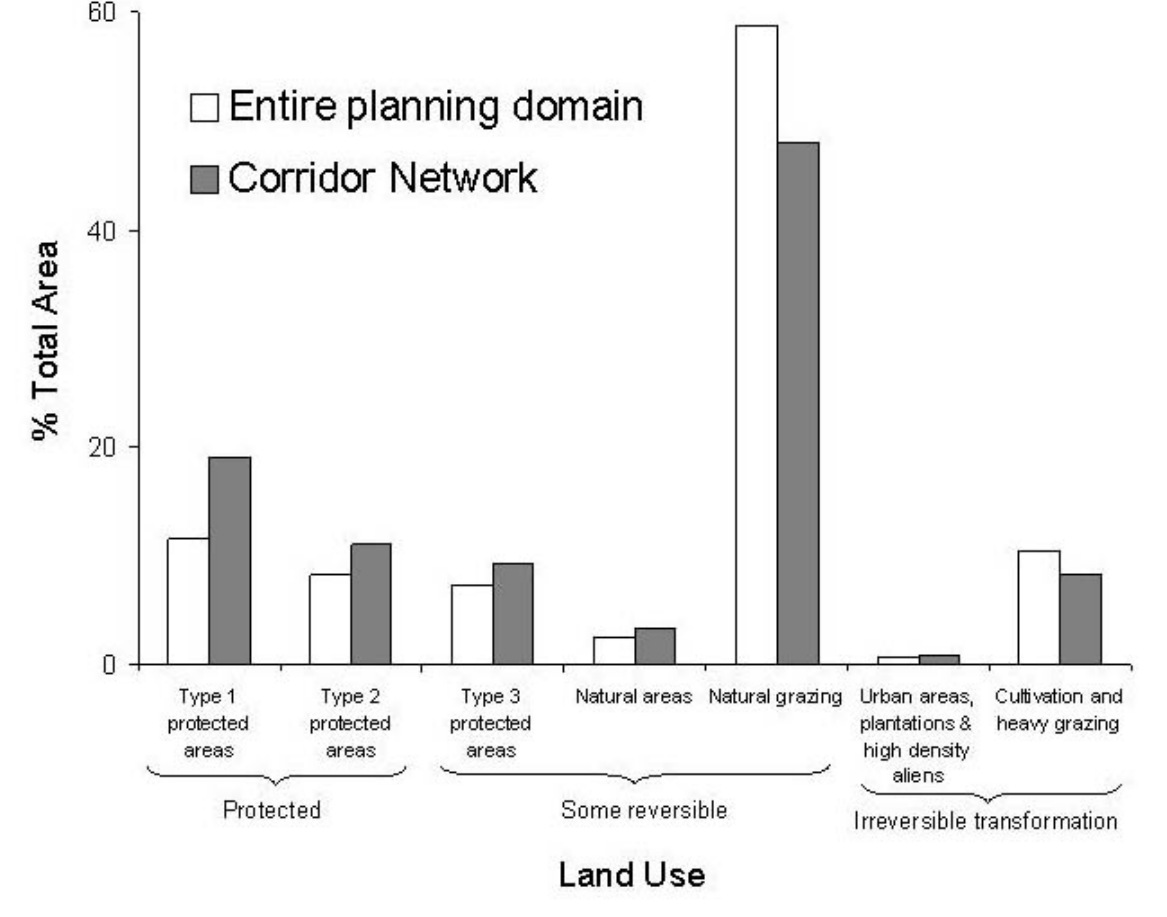
Fig. 5. The percentage areas of different land uses in the entire Gouritz planning domain, and in the corridor network only. Types 1 and 2 protected areas are described in the text. Type 3 protected areas include game farms, state land, or proposed conservation